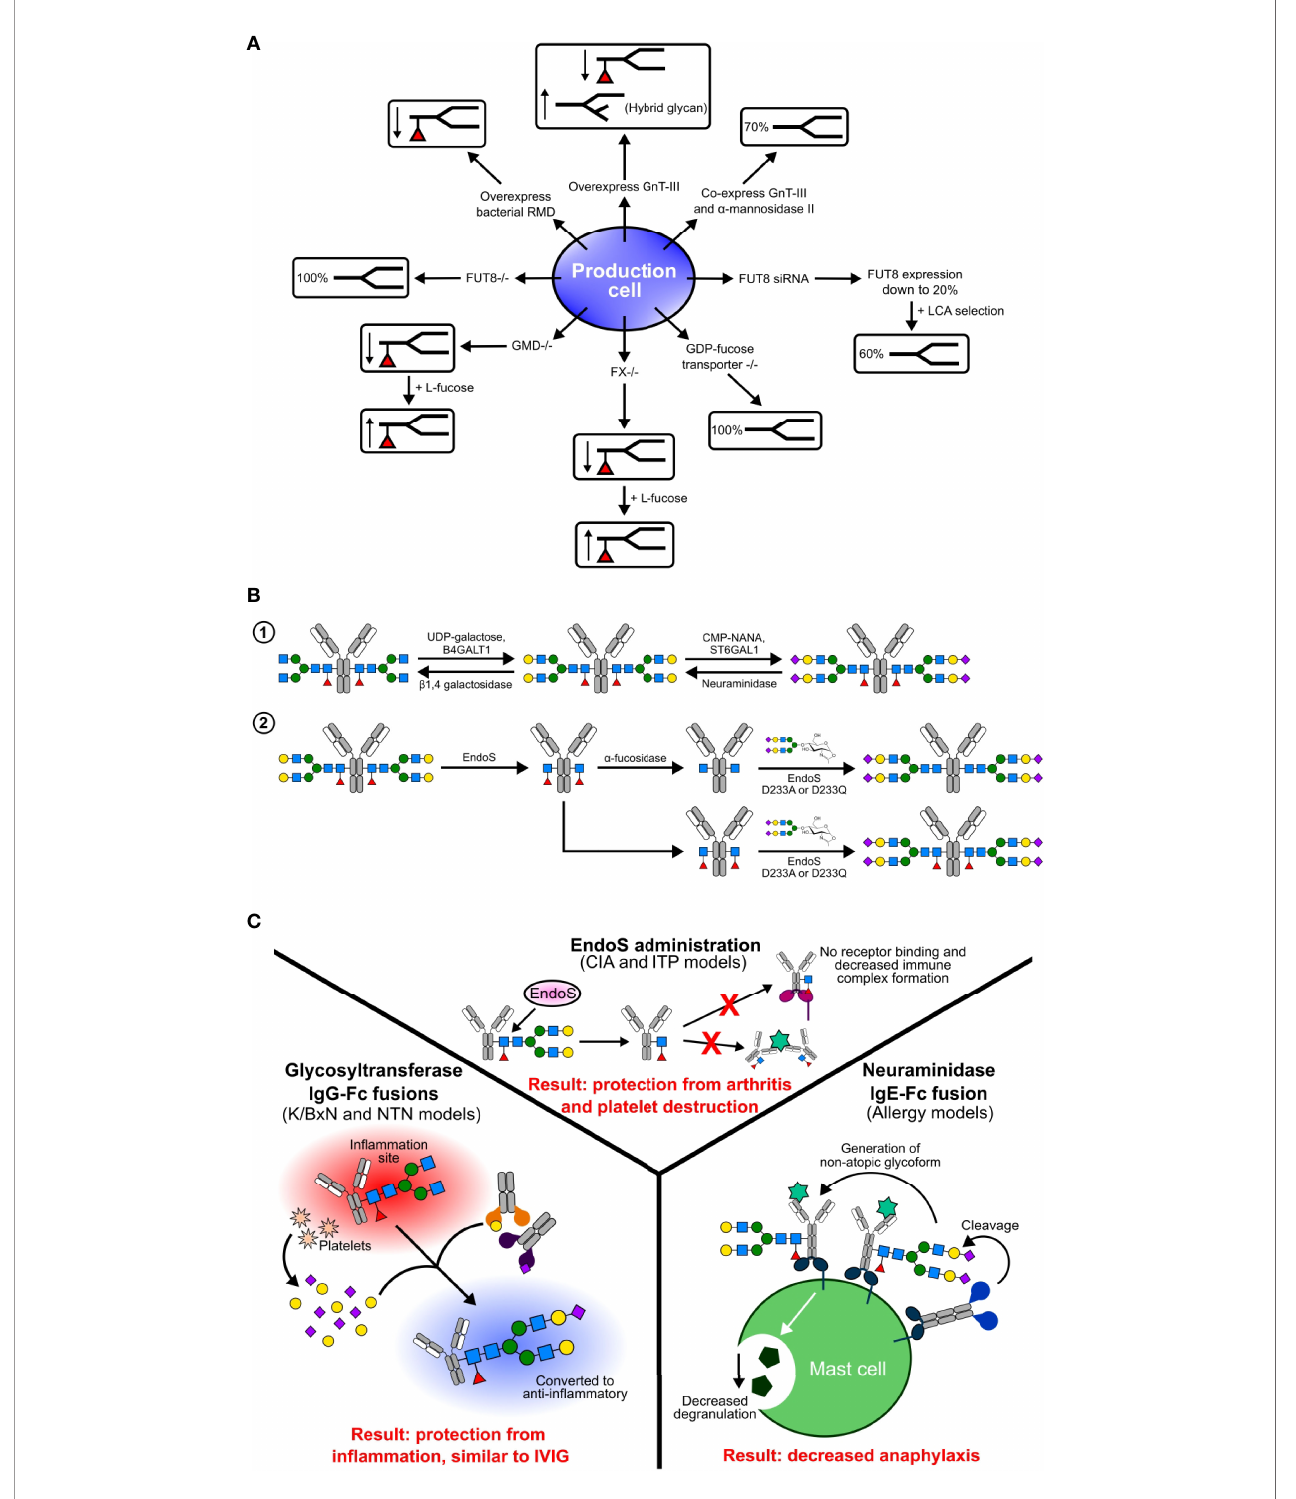
FIGURE 3 | Glycoengineering methods in production cell lines (A) , in vitro (B) , and in vivo (C) . (A) Various genetic manipulations have been performed in production cells to produce differentially fucosylated antibodies. In some cell lines, such as GMD and FX knockouts, fucosylation can be rescued by the addition of substrates such as L-fucose. (B) In vitro methods of glycoengineering and sialylation include step-wise enzymatic building of glycans and chemoenzymatic engineering. (C) In vivo glycoengineering involves administration of enzymes, and have had success in some pre-clinical animal models and on human